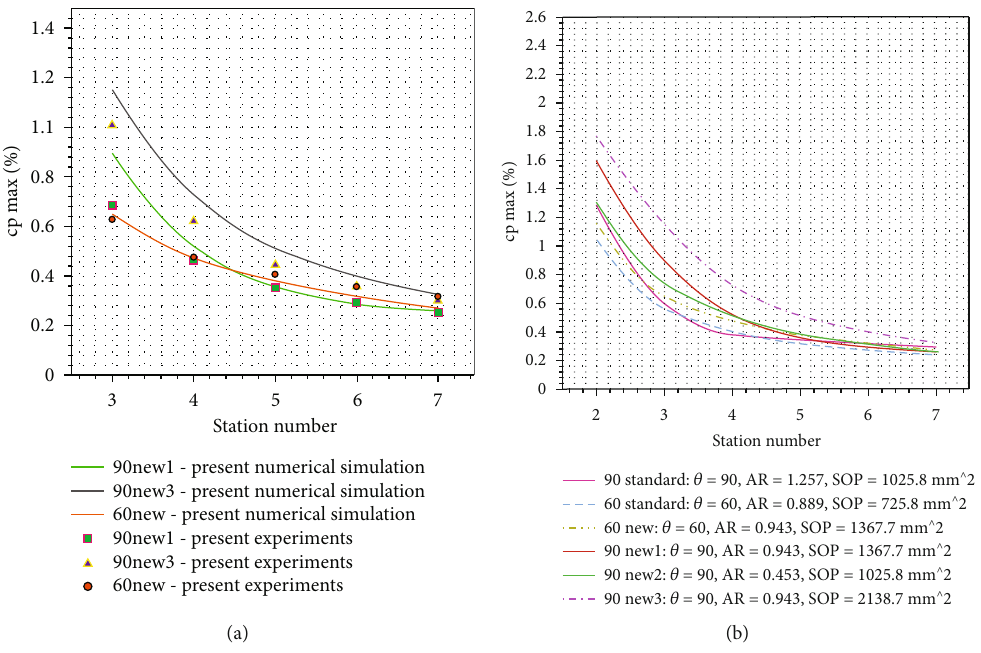
Figure 6: Max cp values at di ff erent stations. (a) Comparison of test and simulation results. (b) Comparison of standard and modi fi ed airfoils values obtained from the present numerical simulation.